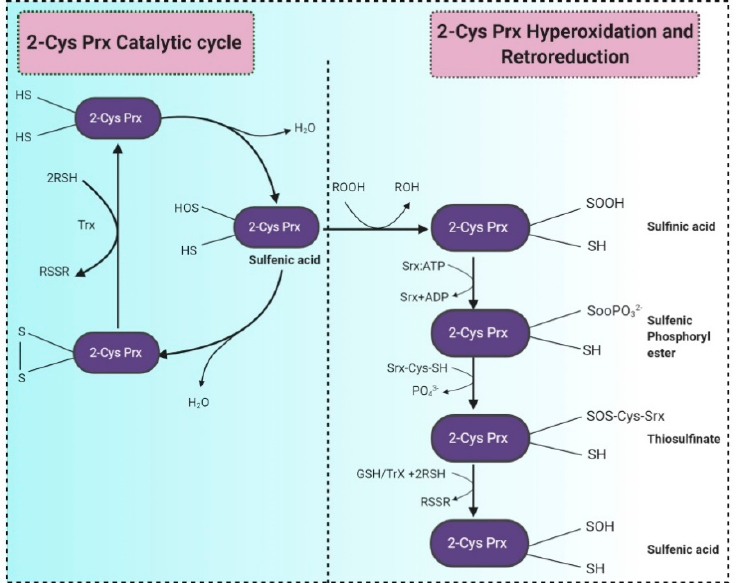
Figure 4. Two-step catalytic mechanism of 2-Cys Prx. The sulfhydryl group at the 2-Cys Prxs is oxidized to sulfenic acid (–SOH), which condenses with the –SH group at the cysteine from the other subunit forming an inter-subunit disulfide bond. This bond is further reduced by thioredoxin (Trx) or another reductase. Continuous peroxide signaling leads to reversible hyperoxidation and formation of sulfinic acid (–SOOH) at peroxidatic cysteine. Sulfinic 2-Cys Prx is reduced by sulfiredoxin (Srx) with an ATP’s consumption and generates a sulfinic phosphoryl ester intermediate. Cys 99 present in Srx reacts with this intermediate to form thiosulfinate that can be attacked by RSH to generate sulfenic acid. (RSH signifies a thiol equivalent such as glutathione, dithiothreitol, or thioredoxin). Adapted from [140].